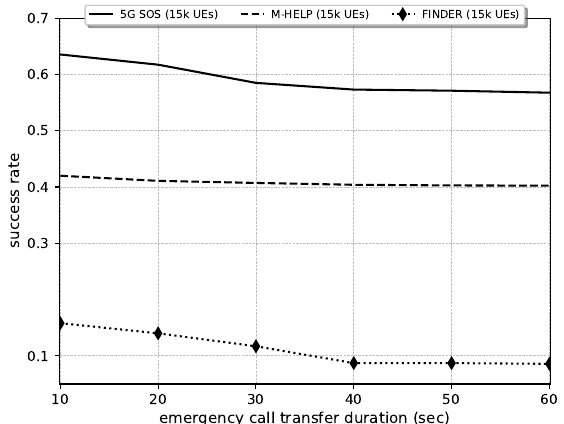
Figure 12. Comparison of successful rate against emergency call transfer duration under 5G-SOS, M-HELP, and FINDER. Parameters: NoU: 15,000, NEC: 5000, ETI: 1800 s (30